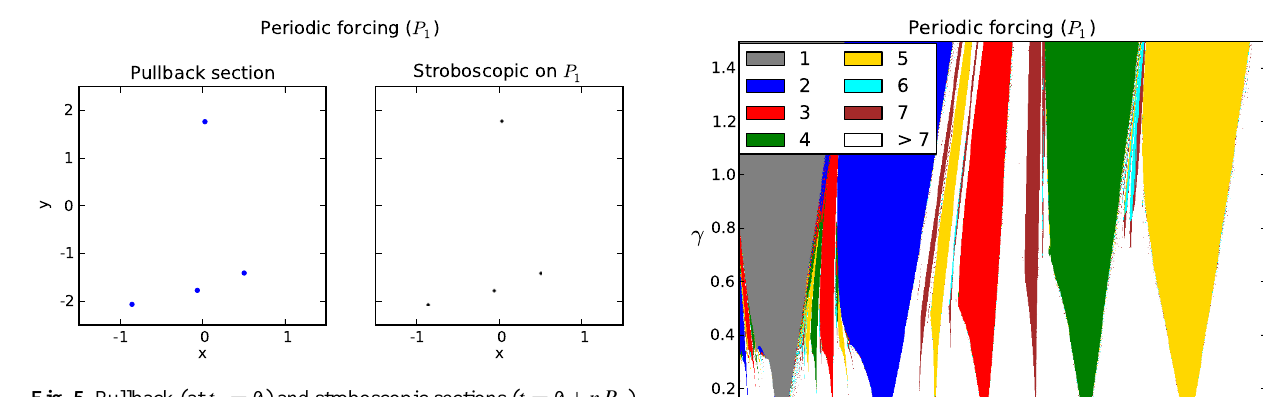
5 Fig. 6. Bifurcation diagram obtained by counting the number of points on the pullback section in the van der Pol oscillator ( α = 30, β = 0 . 7) and F(t) = γ sin ( 2 π/P 1 t + φ P 1 ) . The two x axes indicate τ and the ratio between the natural system period and the forcing, respectively. One observes the synchronisation regimes correspond- ing to 1 : 1, 1 : 2, 1 : 3, 1 : 4 and 1 : 5, respectively (gray, blue, red, green, yellow) and, intertwined, higher order synchronisations in- cluding 3 : 2, 5 : 2, 2 : 3 etc. White areas are weak or no synchro- nisation. Graph constructed using t back = − 10Ma (see Fig. 11 and text for meaning and